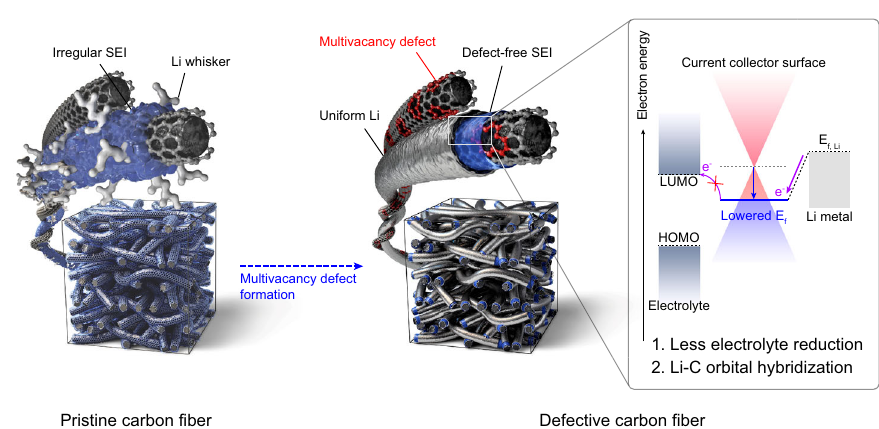
Fig. 1 Schematic of the dual functionality of an electron-de fi cient carbon surface. Pristine carbon fi ber electrode with a graphitic surface (p-CP) forming a nonuniform SEI (blue layer) and dendritic Li deposit (silver color protrusion), and defective carbon layer-decorated carbon fi ber electrode (d-CP) inducing a defect-free SEI and dendrite-free Li morphology. Suppression of electron transfer to the electrolyte on the defective carbon surface of d-CP via a lower Fermi level (larger work function) in contrast to the graphitic carbon surface of p-CP. Orbital hybridization between the lithium deposits and carbon defects on the defective carbon surface of d-CP due to its low Fermi level.